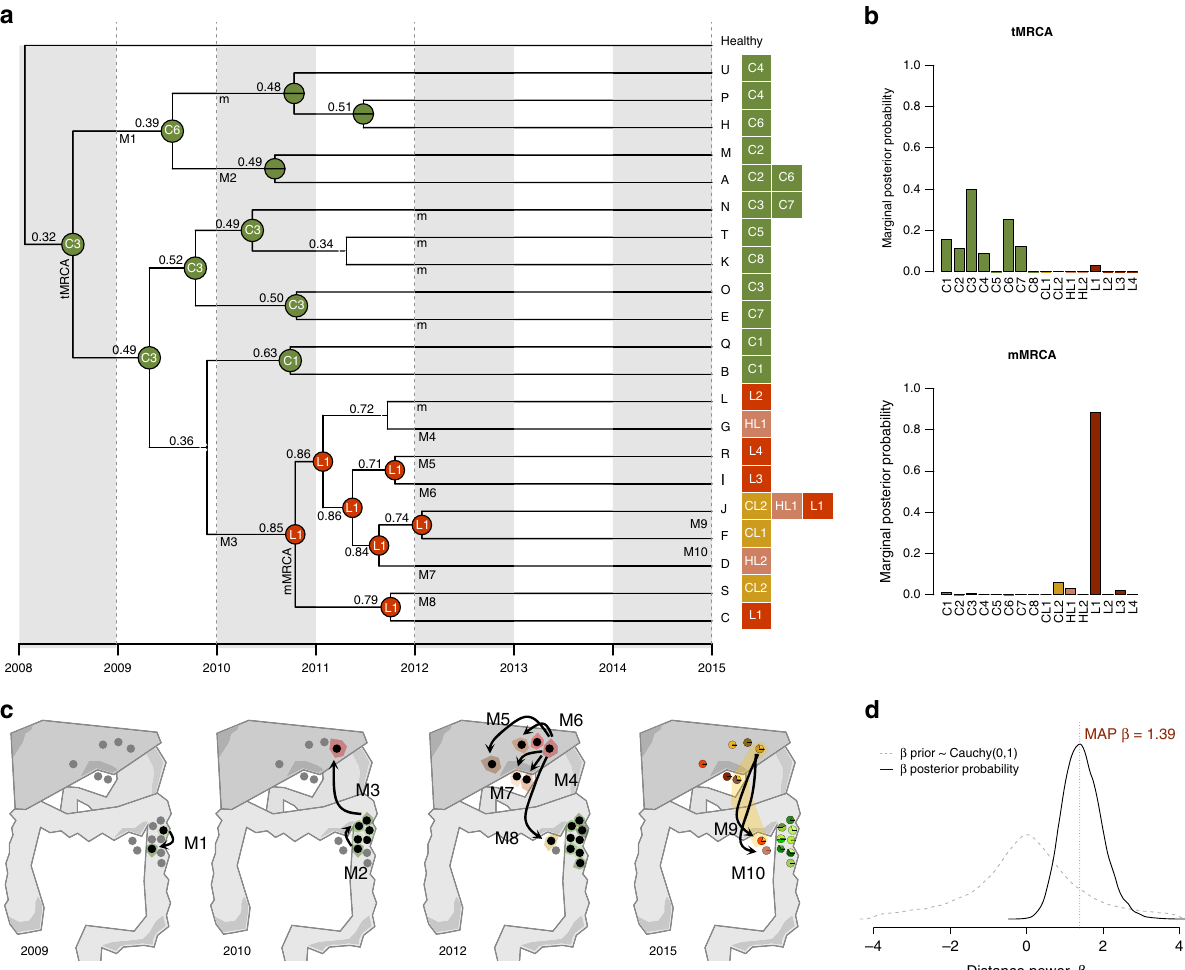
Fig. 3 Inferred biogeographic history. a Biogeographic reconstruction from BayArea, describing the geographical range (i.e., the set of occupied locations) of the ancestral clones. At each tree node, the range with the highest posterior probability is depicted. The sample ID is shown for those ancestral nodes whose inferred area ranges are restricted to a single location. The locations where the extant clones (A – U) were sampled are shown next to the tips. Migration events are depicted in the panel below represented by an uppercase “ M ” and numbered (M1 – M10). A lowercase “ m ” indicates the remaining migrations inferred. b Marginal posterior probabilities for the occupancy at single locations for the tumoral (tMRCA) and metastatic (mMRCA) ancestral clones. c Schematic representation of the clonal dynamics in anatomical space over four time points. From 2009 to 2012, samples where BayArea inferred the presence of tumor clones are highlighted in black. Colored areas surrounding samples anatomical location represent the inferred spatial distribution of the clonal populations. Arrows highlight the inferred migration events. d Comparison of the distance-dependent/independent dispersal models. The dashed gray line corresponds to the prior distribution for the distance power parameter, β ~Cauchy(0,1). The solid black line indicates the posterior distribution obtained. The vertical dashed red line indicates the maximum a posteriori estimate of Population structure . To test the existence of population genetic structure in 0.7, maxVAFAbsent = 0, minClusterSize = 2, minPrivateClusterSize = 1, max- anatomical space, we assessed the correlation between genetic (measured via F ST ClusterDist = 0.1, outputTrees = 1 (Supplementary Fig. 3). estimates) and geographical distance, using the Mantel test function in the ade- genet R package 28 (Supplementary Fig. 1). Phylogenetic model fi tting, reconstruction, and dating . Bayesian phylogenetic analyses were performed using BEAST 2.4.7 (ref. 29 ). First, the most appropriate Deconvolution of clonal populations . Since the accuracy of the clonal deconvo- evolutionary model (i.e., demographics and substitution rates) for our data was identi fi ed using Bayes factors 30 . A detailed description of the models tested can be lution from mixed samples largely depends on the quality of the inferred VAFs, and copy-number variation is known to alter the allele frequency of somatic found in Supplementary Table 1. For each candidate model, marginal likelihoods mutations in bulk tumor samples, somatic calls showing a VAF <0.10, with a read were obtained through a path-sampling analysis implemented in BEAST, using 100 depth <20 in all tumor and healthy samples, and/or overlapping with copy-number independent Markov Chain Monte Carlo (MCMC) chains with 500,000 steps each. events were fi ltered out prior to clonal deconvolution. The number of tumor As a prior for the relaxed clock rate mean, a value of 4.6E-10substitutions per site clones, as well as their genotype sequences, was then inferred using CloneFinder 13 , per generation derived experimentally for CRC 16 was used. For conversion to real which has been previously shown to outperform other methods in both simulated time, a generation time of 4 days was assumed 16,31 . Moreover, since the clonal and empirical datasets. We required a minimum read count of 40 and a mutant genotypes obtained only comprise variable genomic positions, an SNV ascertain- read count of 6. The clone frequency cutoff was set to 0.075. The binary clonal ment bias correction 32 was applied by modifying the “ constantSiteWeights ” sequences generated (i.e., A = reference status; T = alternative alleles) were then attribute in the input XML fi le for BEAST. Posterior distributions under the model modi fi ed by changing the binary alleles into the corresponding nucleotide state. with highest support (i.e., Clock Model: Relaxed clock exponential; Tree: Coales- The consistency of the clonal genotypes inferred was evaluated by applying a cent Exponential Population) for the parameters of interest were obtained by different clonal deconvolution method, LICHeE 20 , to the same dataset. LICHeE running an MCMC chain during 100 million generations, sampled every 2000. Convergence was assessed using Tracer v1.6 (ref. 33 ). After discarding the fi rst 10% was run using the following thresholds: minVAFPresent = 0.075, maxVAFValid =